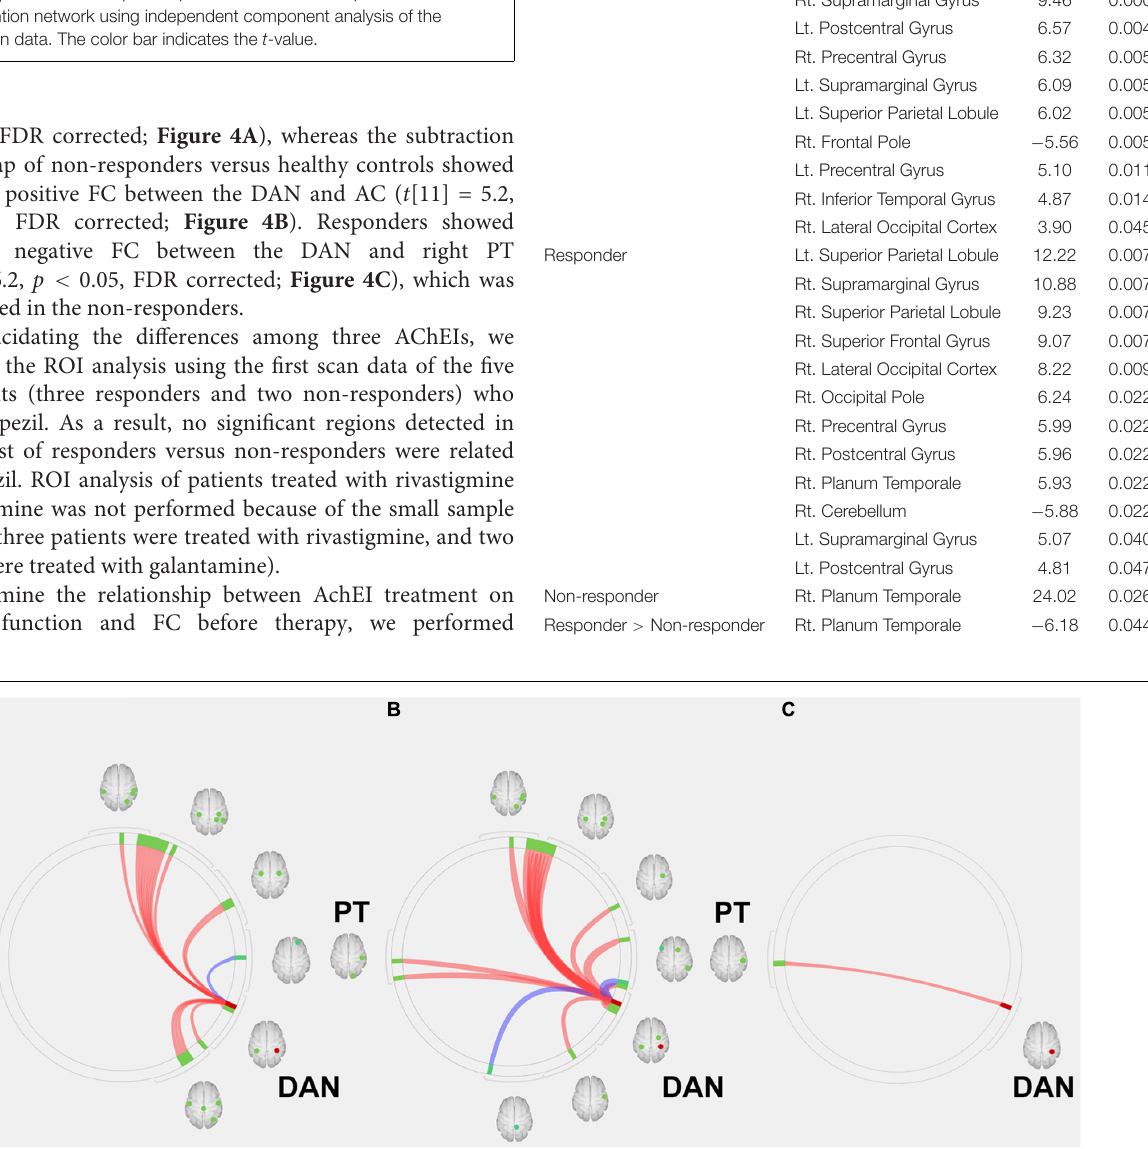
FIGURE 3 | Region of interest (ROI)-to-ROI connectivity values for regions significantly ( p < 0.05 false-discovery rate corrected) connected with the dorsal attention network in (A) healthy subjects, (B) responders, and (C) and non-responders. Red and blue lines indicate positive and negative connectivity, respectively. Red circles indicate the seed (DAN), and green circles indicate significant ROIs. DAN, dorsal attention network; PT, planum temporale.